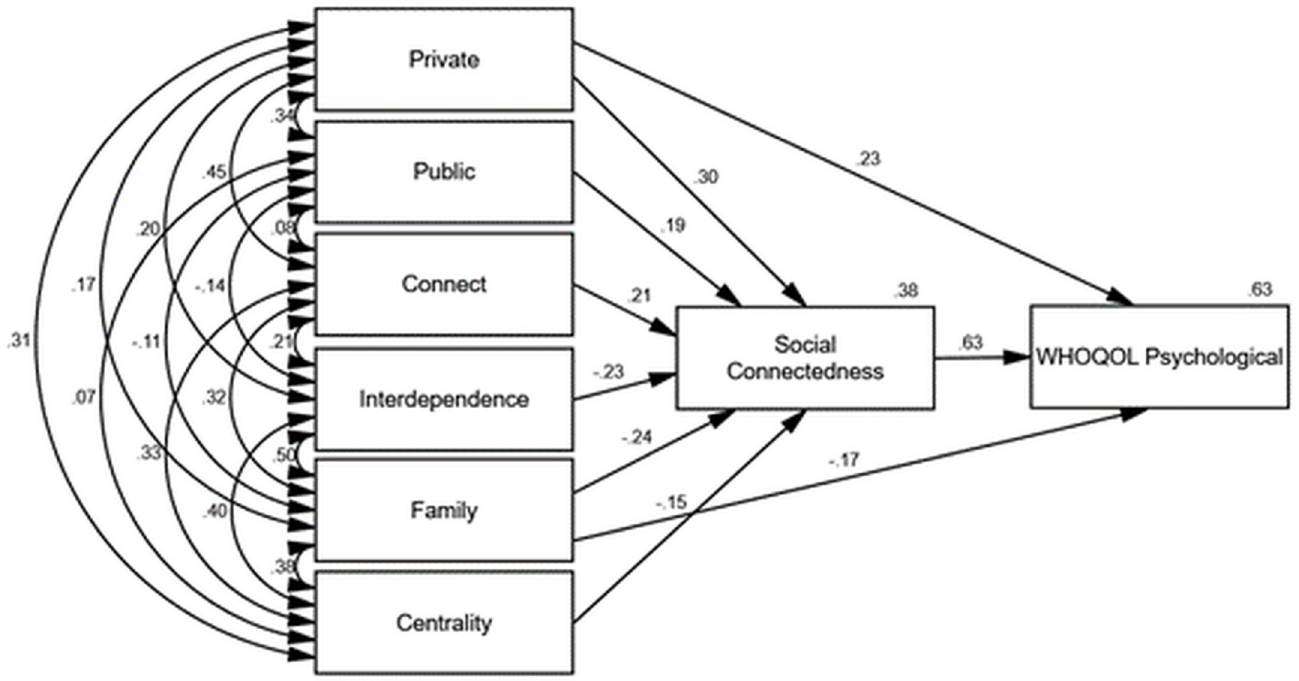
Fig 4. Final path model with standardised parameter estimates WHOQOL-Bref psychological domain (transformed).